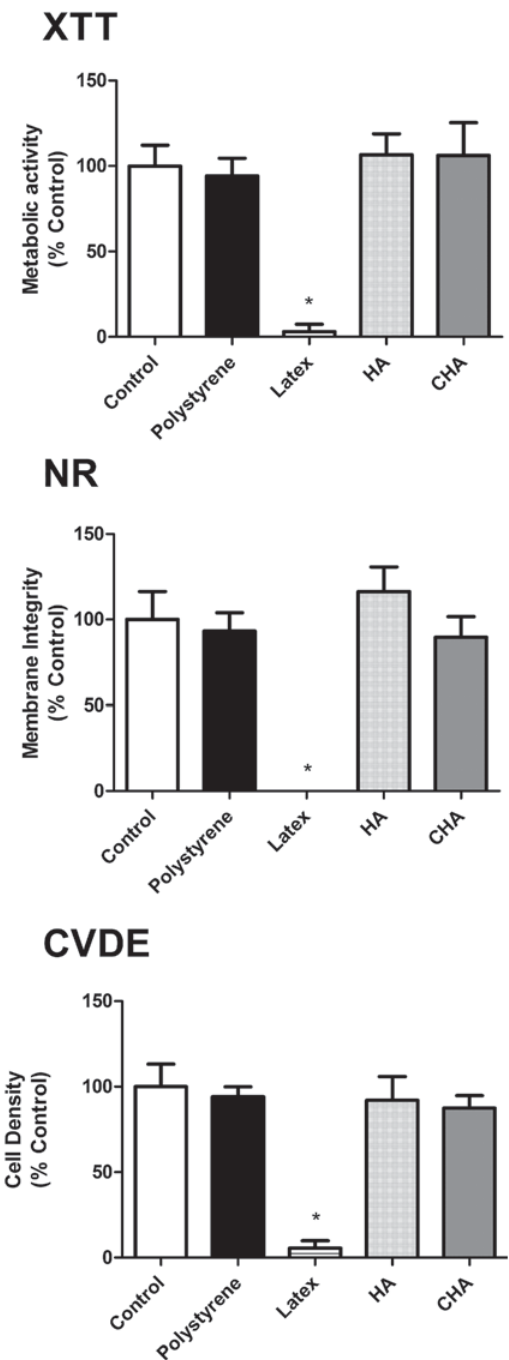
Figure 4- Multiparametric cytotoxicity assay with murine MC3T3-E1 cells. Results showed as percentage of (cid:70)(cid:82)(cid:81)(cid:87)(cid:85)(cid:82)(cid:79)(cid:3)(cid:74)(cid:85)(cid:82)(cid:88)(cid:83)(cid:3)(cid:11)(cid:38)(cid:82)(cid:81)(cid:87)(cid:85)(cid:82)(cid:79)(cid:30)(cid:3)(cid:72)(cid:91)(cid:83)(cid:82)(cid:86)(cid:88)(cid:85)(cid:72)(cid:3)(cid:87)(cid:82)(cid:3)(cid:39)(cid:48)(cid:40)(cid:48)(cid:12)(cid:17)(cid:3)(cid:13)(cid:3)(cid:143)(cid:3)(cid:68)(cid:79)(cid:79)(cid:3)(cid:87)(cid:75)(cid:72)(cid:3) other groups